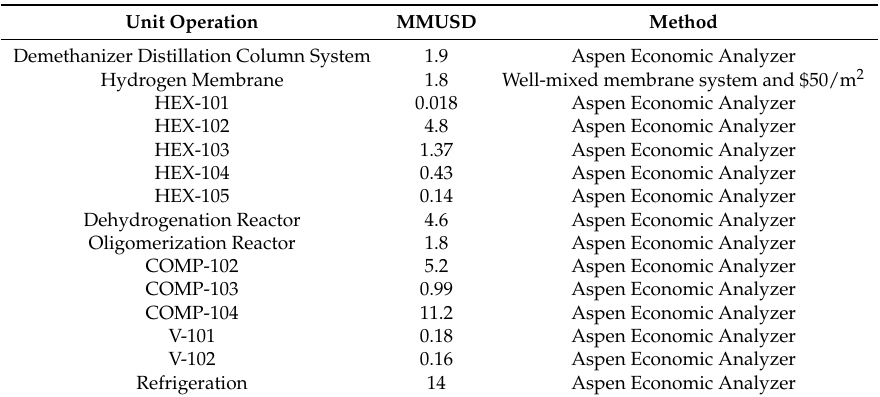
Table A1. Equipment cost for unit operations in Process I.